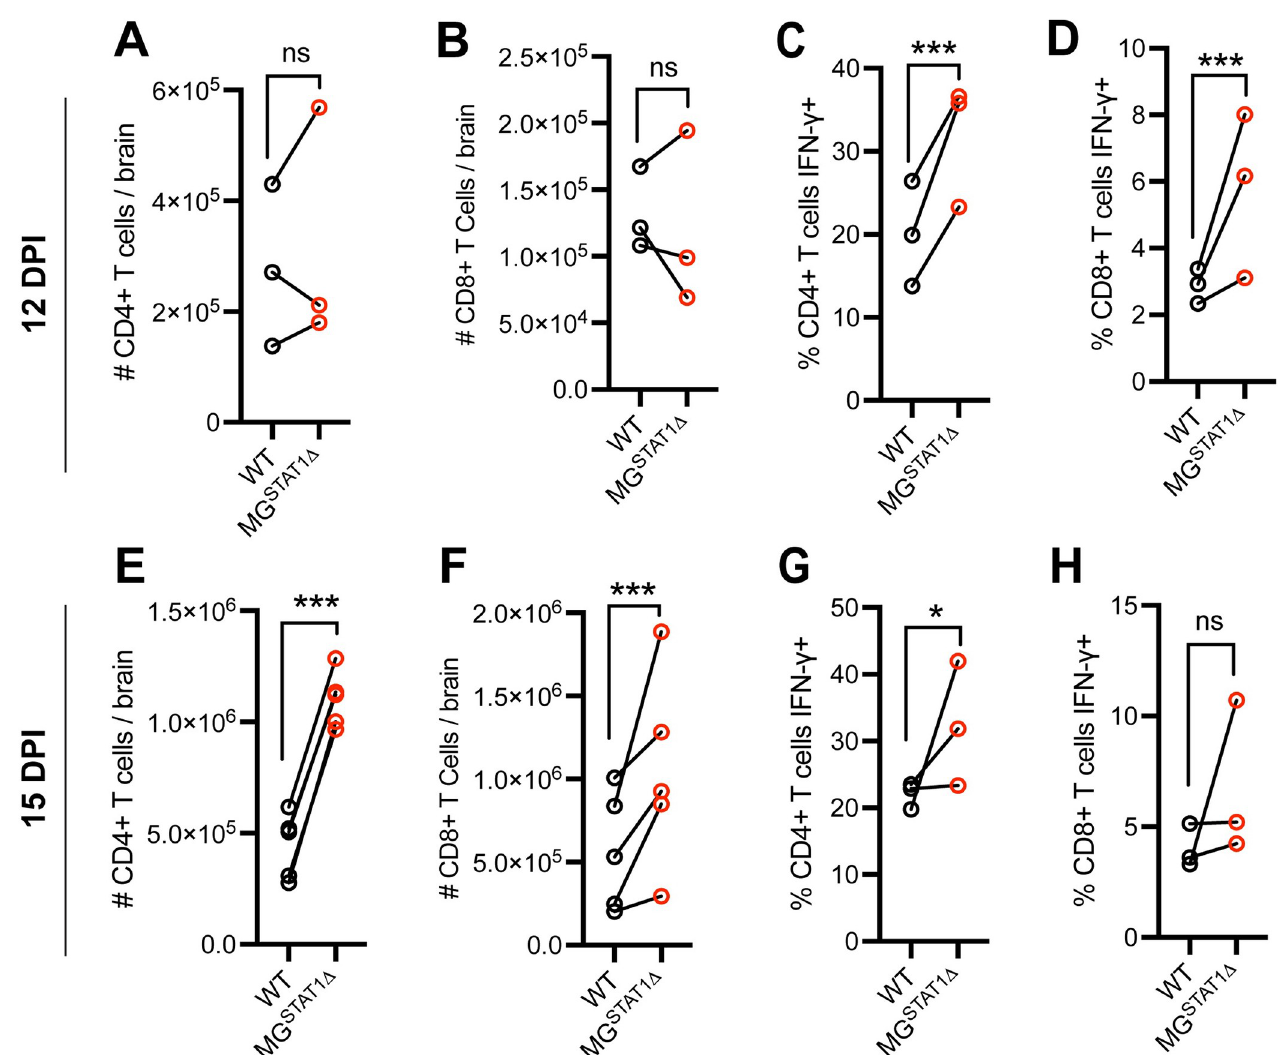
Fig 4. Brain T cell responses are increased in MG STAT1 Δ mice relative to WT controls. WT and MG STAT1 Δ mice were intraperitoneally infected with 10 cysts of the Me49 strain of T . gondii and brains were analyzed by flow cytometry at 12 and 15 DPI. ( A-B ) CD3+CD4+ and CD3+CD8+ cell count enumerated for whole brain and ( C–D ) IFN- γ protein expression at 12 DPI. ( E-F ) CD3+CD4+ and CD3+CD8+ cell count enumerated for whole brain and ( G-H ) IFN- γ protein expression at 15 DPI. ns = not significant, and ��� = p < 0.001. Statistical significance was determined by two-way randomized block ANOVA. Data are pooled from 3 ( A-D & G-H ), or 4 ( E-F ) separate experiments, with n = 9-10 ( A-B ), n = 11-13 ( C-D ), n = 12-16 ( E-F ), and n = 9-12 ( G-H ) mice per group. Biological replicates are individual mice, with group means from individual experiments plotted as open circles with black lines connecting experimental and control groups. Source data ( A-H ) are provided in a source data